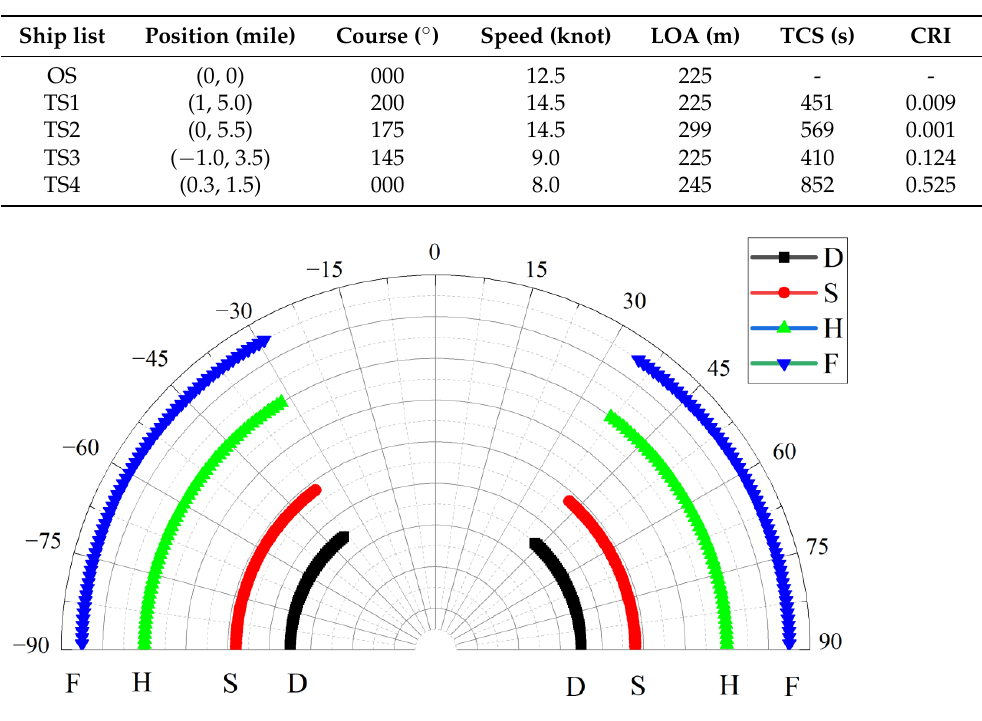
Figure 14. Dynamic feasible manoeuvring interval of scenario 2.